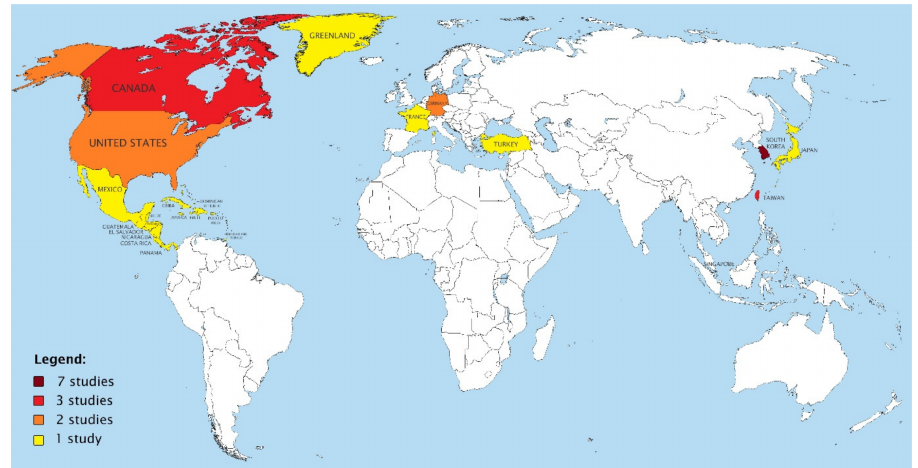
Figure 2. Geographical distribution of studies included in this